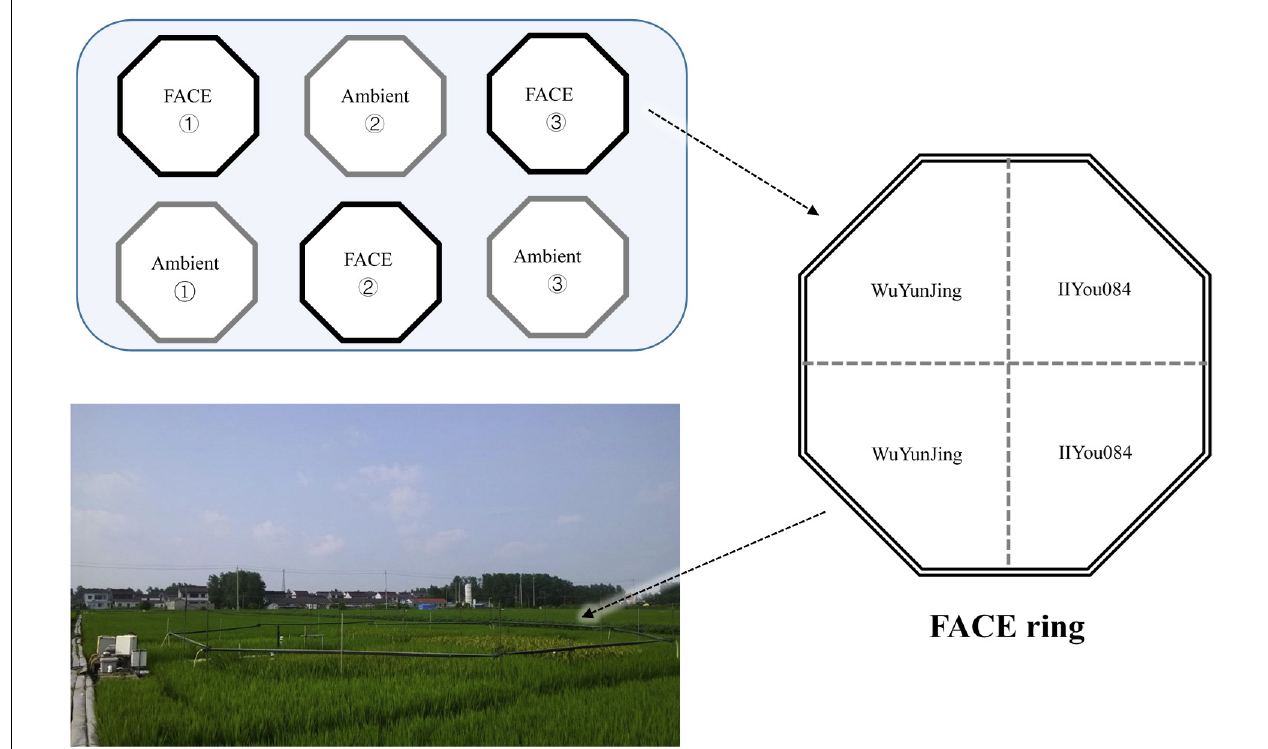
FIGURE 1 | Free-air CO 2 enrichment (FACE) system in Yangzhou City, Jiangsu, China (119 ◦ 42 (cid:48) 0 (cid:48)(cid:48) E, 32 ◦ 35 (cid:48) 5 (cid:48)(cid:48) N).